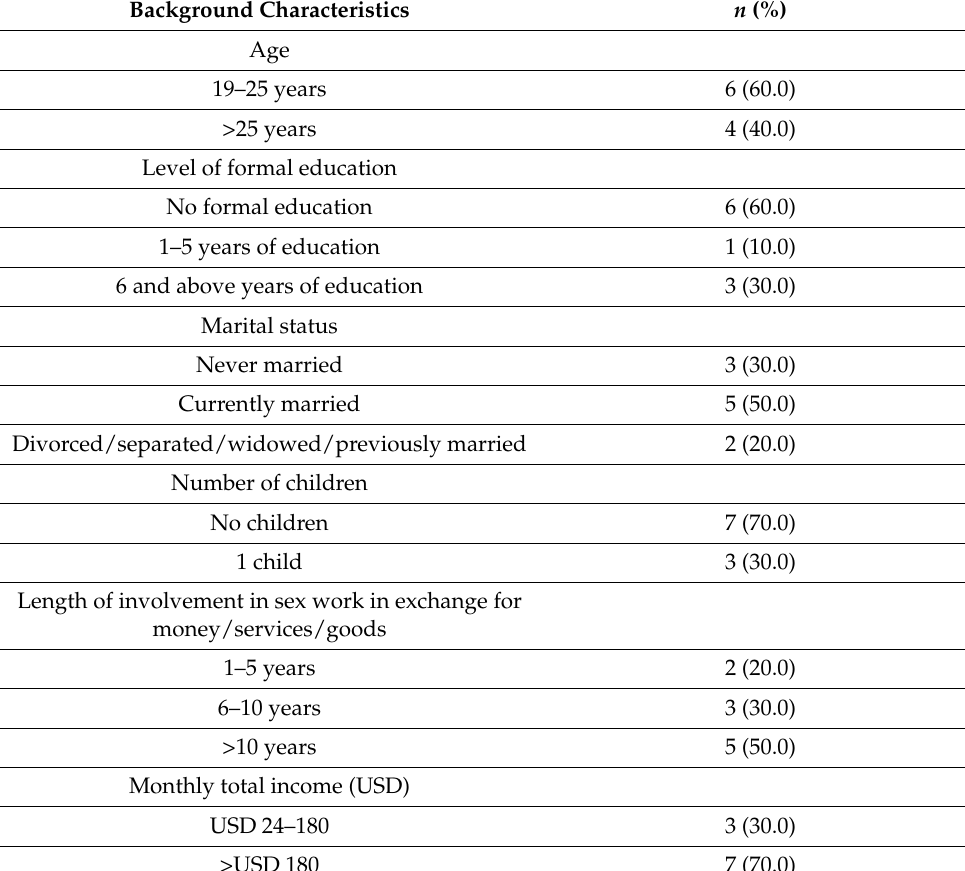
Table 1. Background characteristics of FSWs at the time of interview ( n =